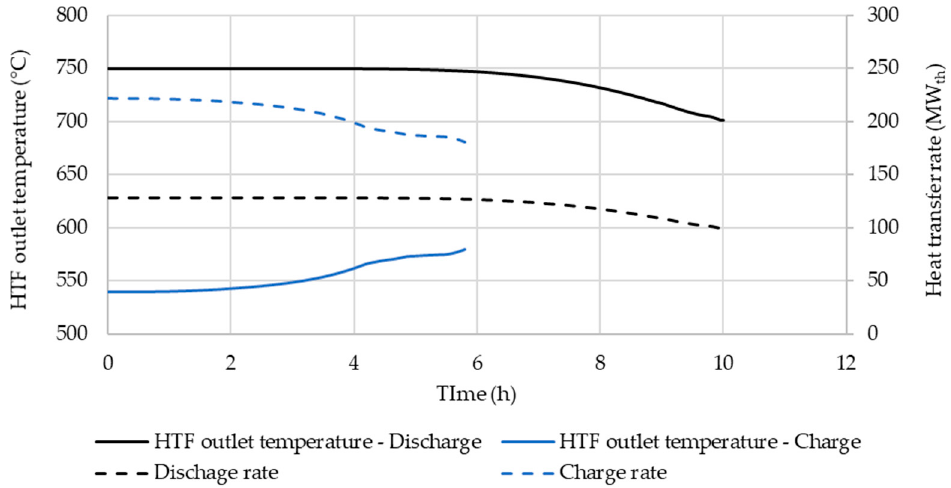
Figure 5. HTF outlet temperature and heat transfer rate for charging and discharging processes.